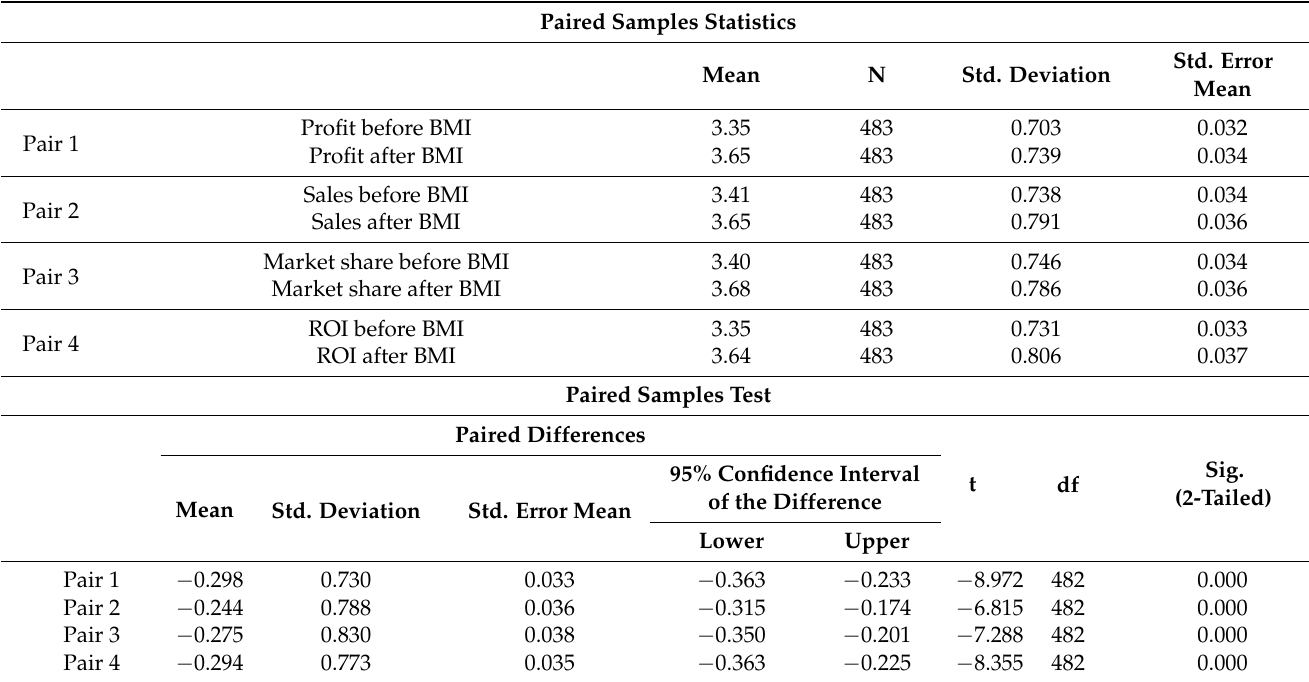
Table 3. Influence of BMI based on new technologies on competitive